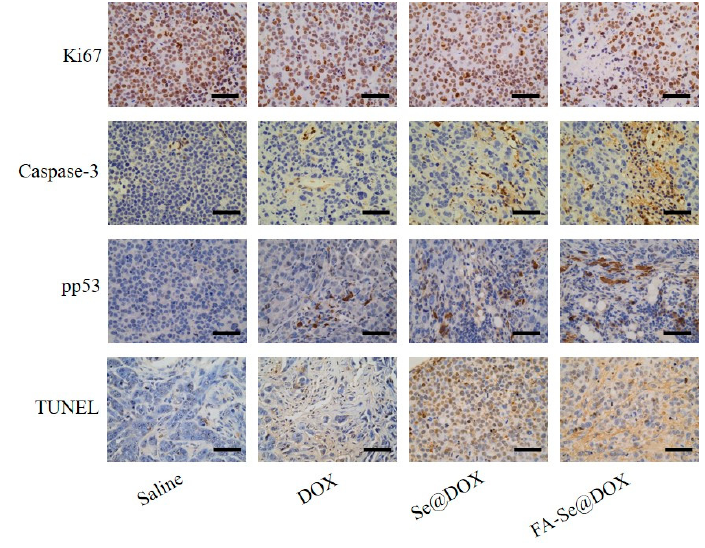
Figure 9. The immunohistochemical analysis of the tumor tissues from tumor-bearing mice after treatment with saline, DOX, Se@DOX, and FA-Se@DOX, respectively. Scale bar is 50 μ m.